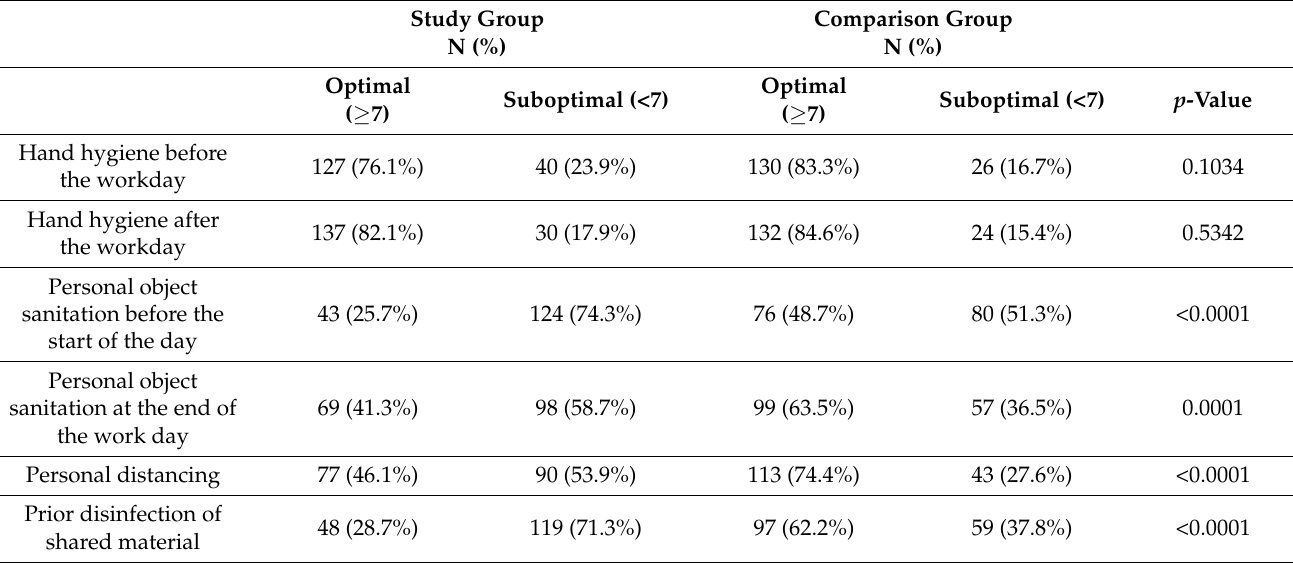
Table 5. Compliance with other protective measures.